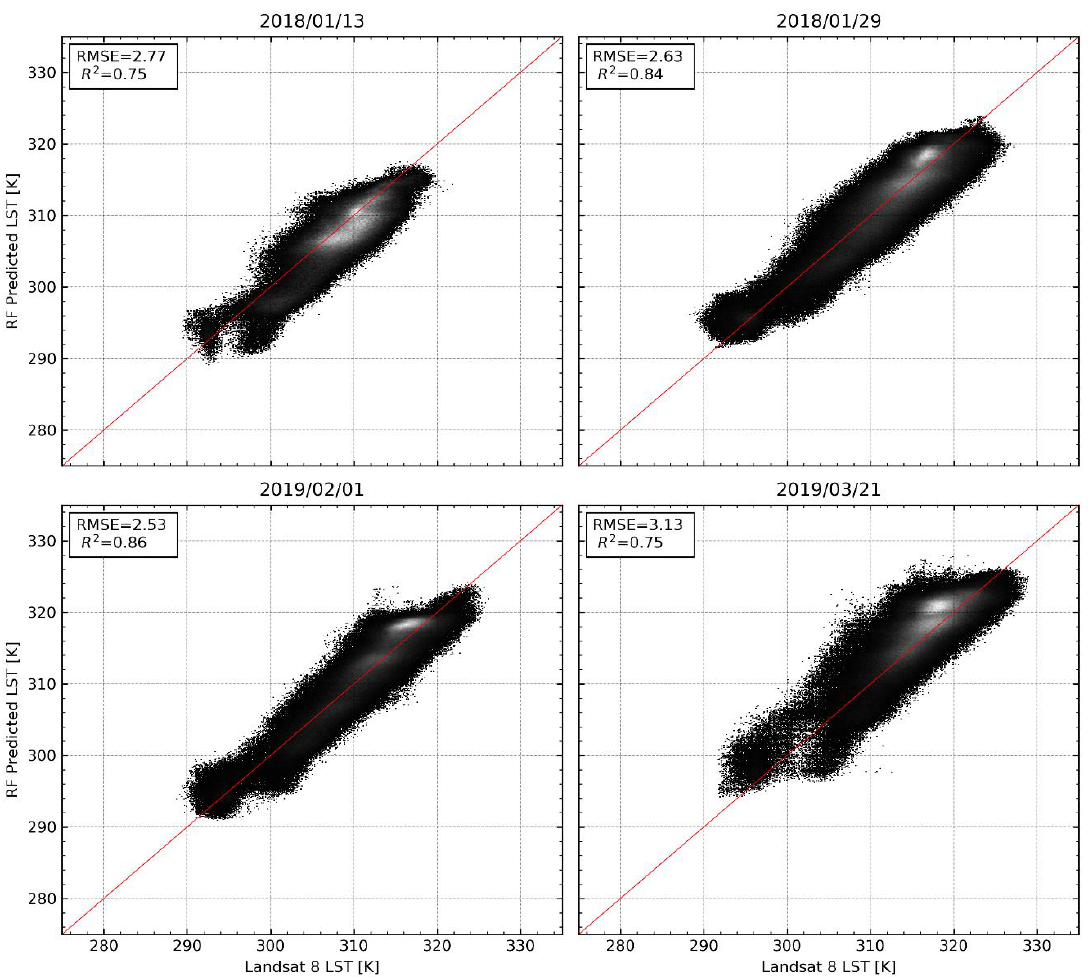
Figure 5. Relationship between Landsat 8-derived LST and RF-predicted LST at 100 m for each day corresponding to the four Landsat 8 overpass dates used in the study.